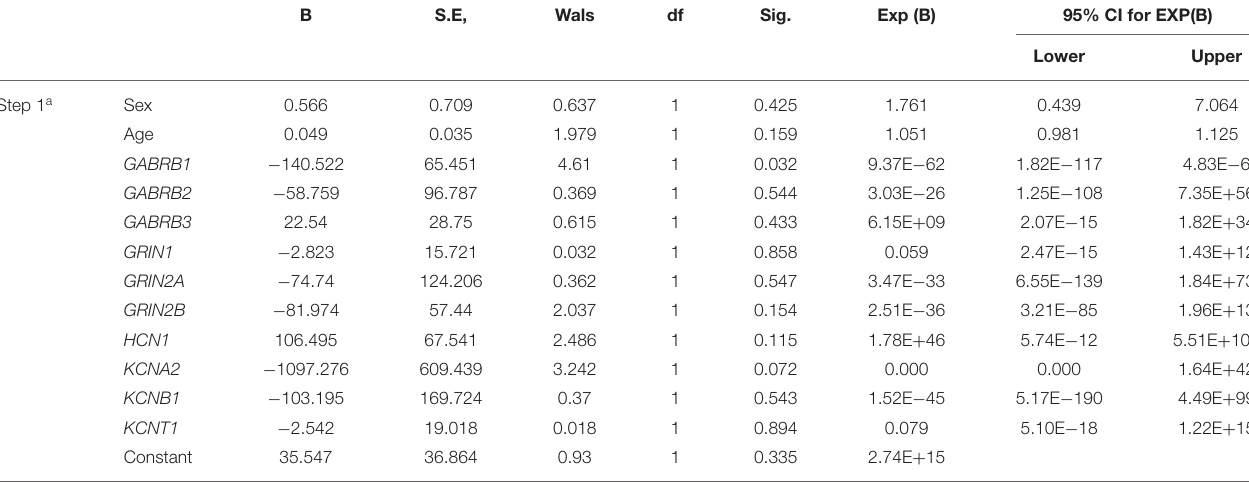
TABLE 4 | Independent risk factors for DNA methylation-related ion channels evaluated by binary logistic regression. B S.E, Wals df Sig.